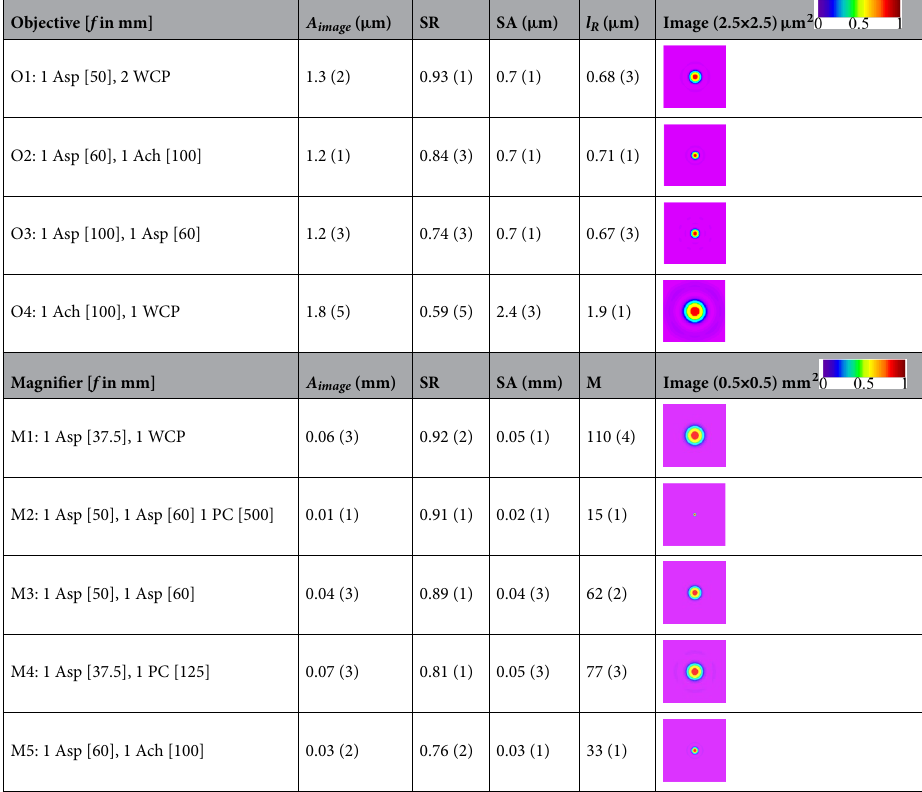
Table 1. Estimated values of parameters for different lens combinations that we studied, where the magnifiers in conjunction with O1 are shown here. Asp asphere, WCP wavefront corrector plate, Ach achromat, PC plano convex